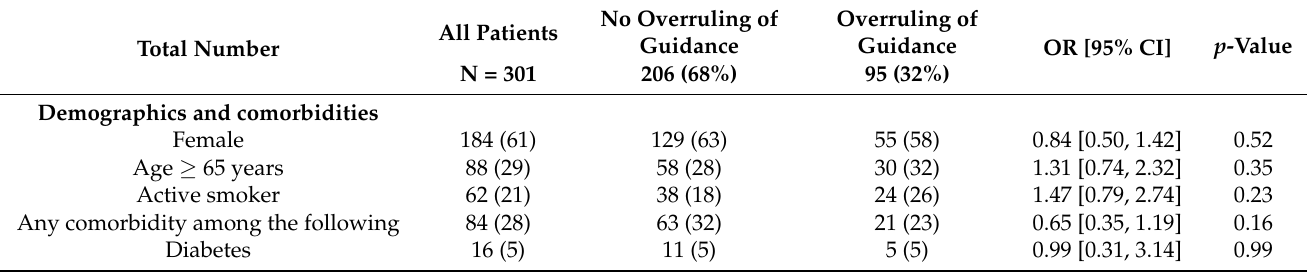
Table 1. Patients’ characteristics, clinical presentation and general practitioners’ characteristics, ac- cording to the overruling of initial procalcitonin guidance: descriptive statistics and univariate logistic regression models. Values are n (% of the corresponding total number), unless stated otherwise. Odds ratios and p -values were calculated from univariate mixed-effects logistic regression and corrected for